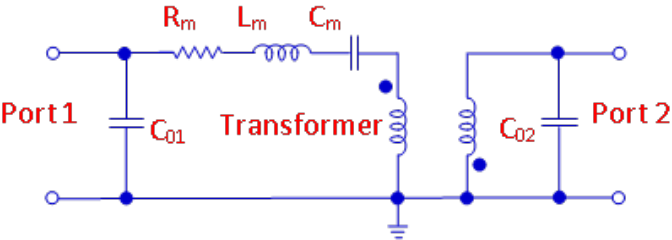
Figure 4. Comparison between (red symbols) measurements and (black line) Lorentzian fitting of Figure 5. Lumped-element equivalent-circuit model for the investigated two-port SAW resonators. the frequency-dependent behavior of Re(Y 11 ) for the 915 MHz SAW resonator.